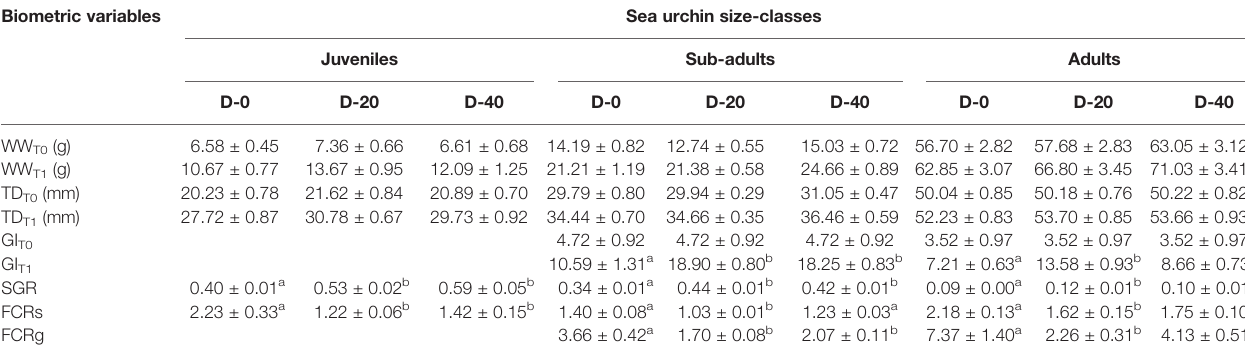
TABLE 1 | Biometric measures (mean ± SE) and growth performances of P. lividus size classes fed with the three experimental diets (D-0, D-20 and D-40). Biometric